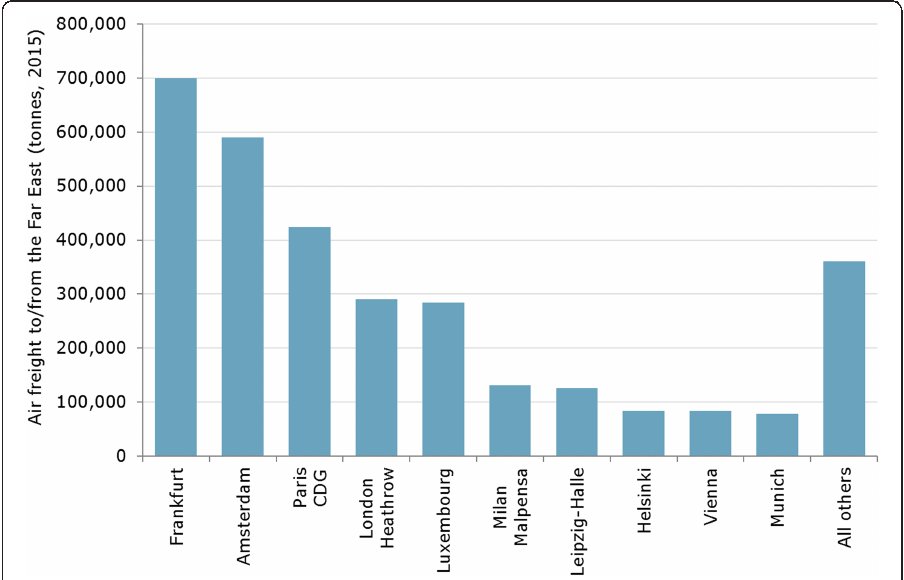
Fig. 4 Ten largest airports in Europe by tonnes of air freight to/from the Far East (2015, from